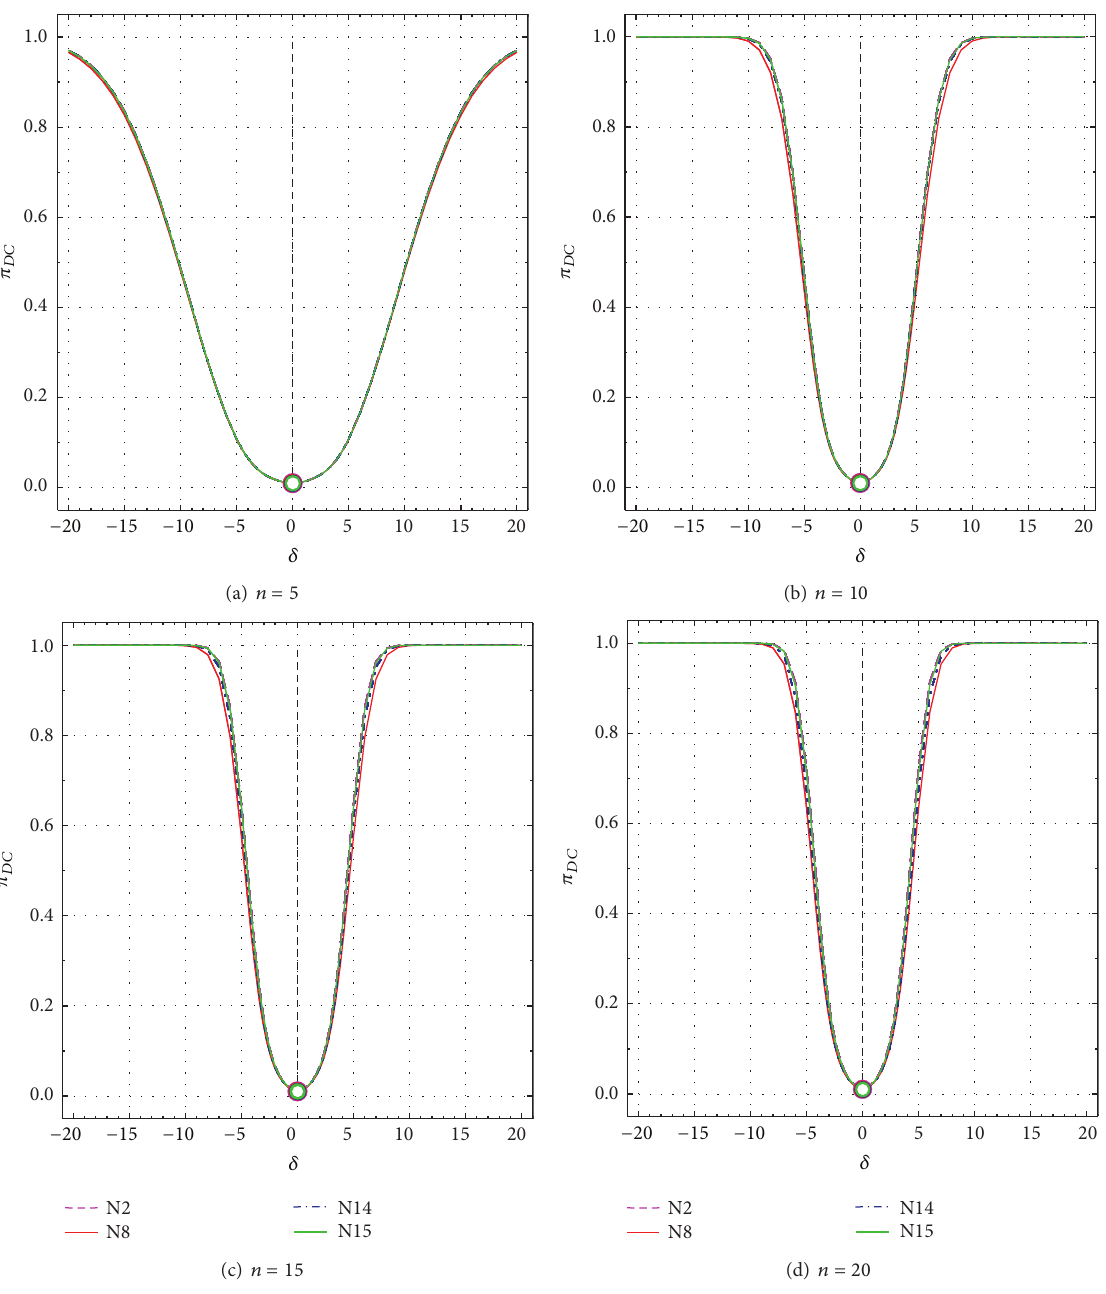
Figure 6: Nonspurious power probability ( 𝜋 𝐷𝐶 ) as a function of 𝛿 from − 20 to +20 for all tests N2, N8, N14, and N15. 𝜋 𝐷𝐶 values for uncontaminated samples ( 𝛿 = 0 ) are shown by open circles. (a) 𝑛 = 5 ; (b) 𝑛 = 10 ; (c) 𝑛 = 15 ; and (d) 𝑛 = 20